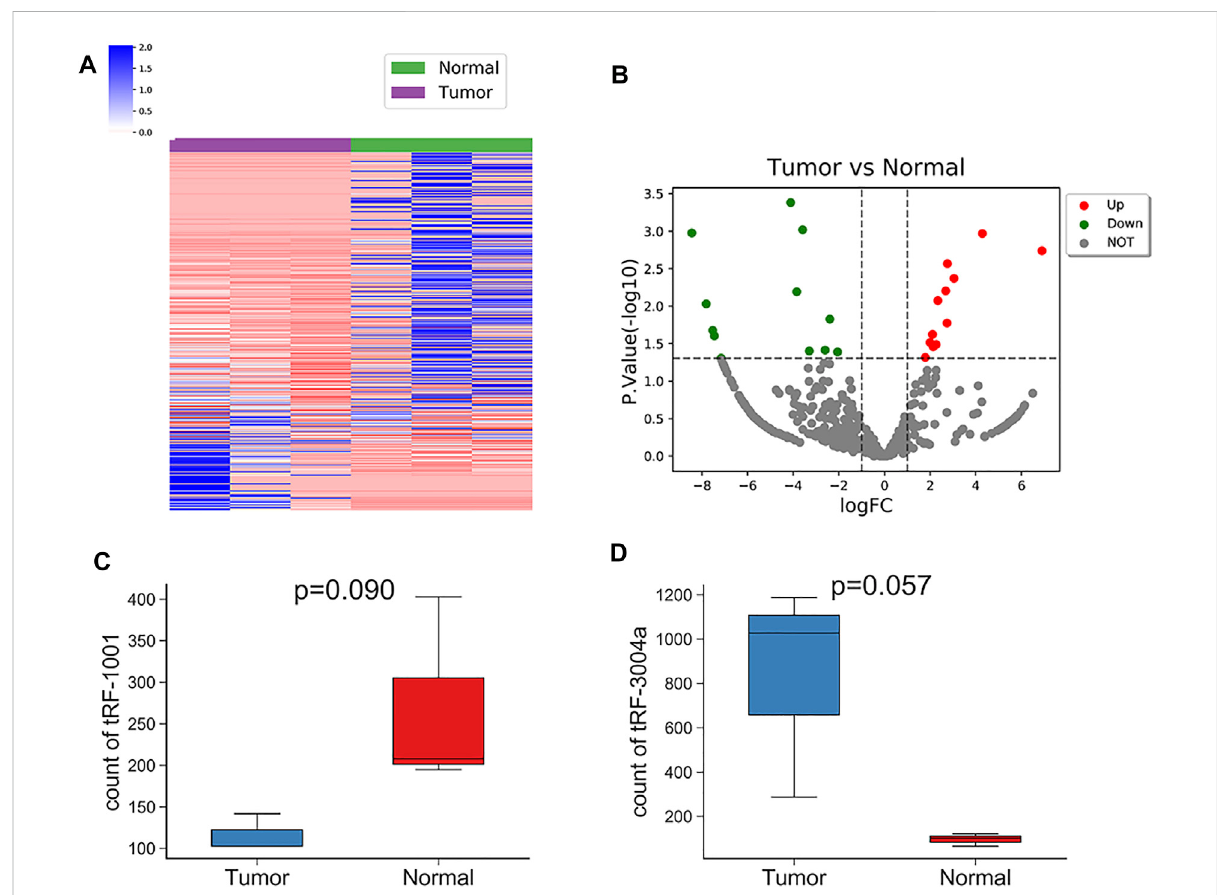
FIGURE 4 Hierarchical clustering and the differently expressed tRFs/tiRNAs between the Exo-LT(T) and the Exo-AT(N) groups. (A) Unsupervised hierarchicalclusteringheatmapoftRFs/tiRNAsfortheExo-ATandtheExo-LTgroups.Thebluecolorrepresentsanexpressionlevelbelowthemean, and red color represents an expression level above the mean. The colored bar on the left side of the panel indicates the division that was performed by K-means. (B) Volcano plot of the tRFs/tiRNAs from the Exo-AT and the Exo-LT groups. The red/green circles indicate statistically signi fi cant differentially expressed tRFs/tiRNAs with fold change not less than 1.5 and p -value ≤ 0.05 (red: up-regulated; green: down-regulated). The gray circles indicate non-differently expressed tRFs/tiRNAs with FC and/or q-value that did not meet the cut-off thresholds. (C) Boxplot of the